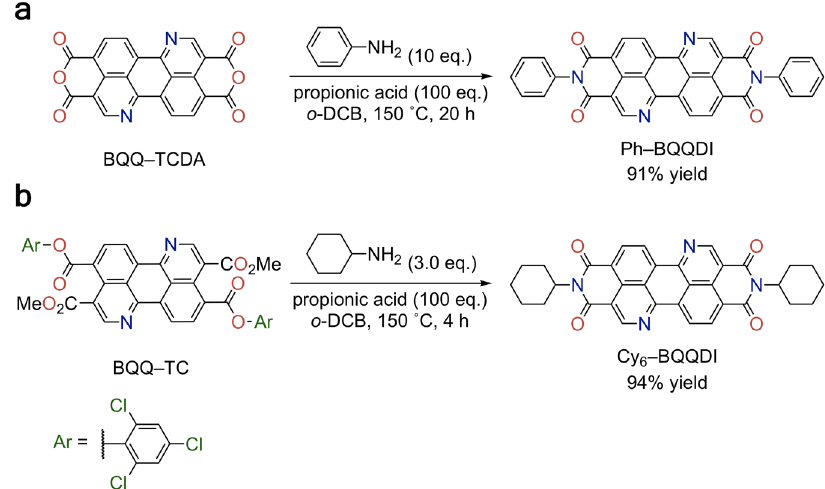
Fig. 2 Synthetic routes for BQQDI derivatives. a Synthesis of Ph – BQQDI from BQQ – TCDA. b Synthesis of Cy 6 – BQQDI from BQQ –